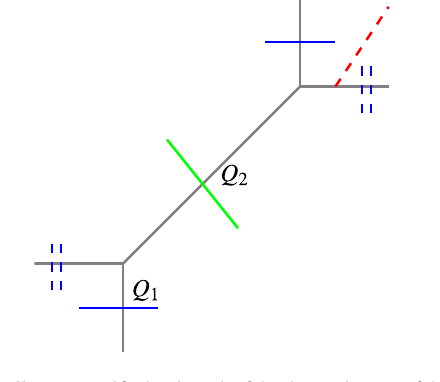
Fig. 9 totallycompactifiedtoricwebofthethetotalspaceofthebundle O ( − 1 ) ⊕ O ( − 1 ) → P